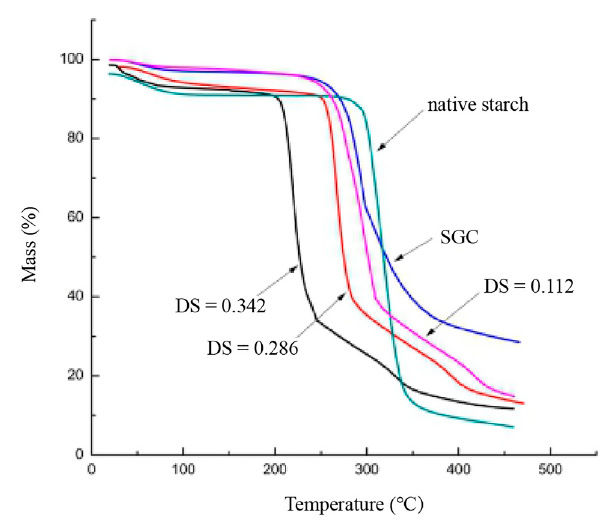
Figure 9. The TGA curves of SGC and OSA–SGC nanoparticles.